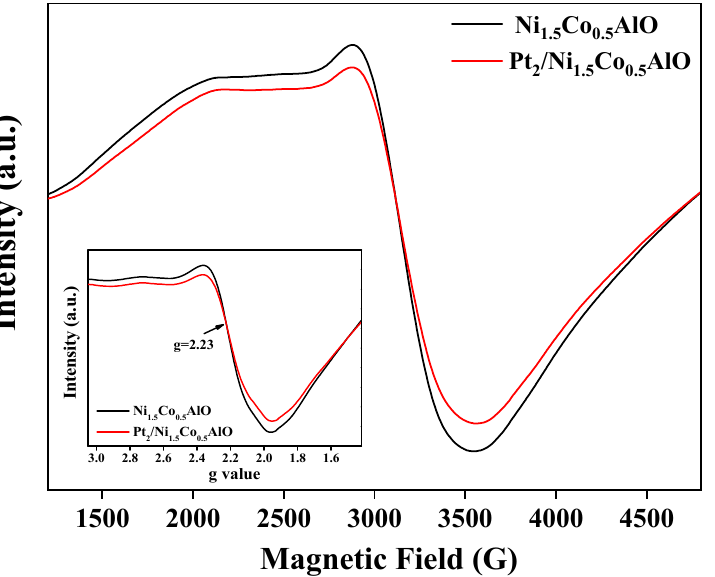
Figure 9. Electron paramagnetic resonance (EPR) spectra of Pt n /Ni 1.5 Co 0.5 AlO catalysts. The inset image exhibits the g value of the Pt n /Ni 1.5 Co 0.5 AlO catalysts.